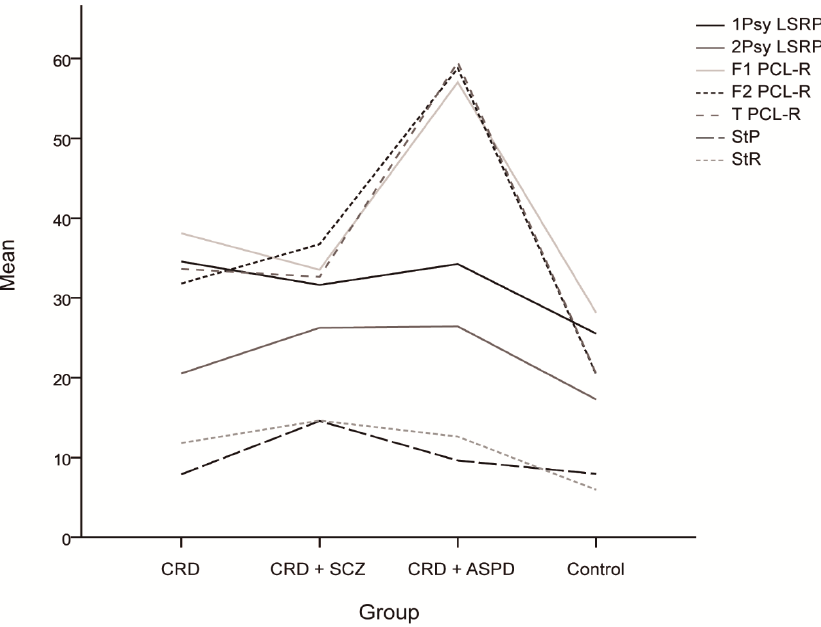
Figure 1. Mean scores and differences between the groups for the psychopathy scales and sensitivity to punishment and sensitivity to reward questionnaire. CRD: cocaine-related disorder; SCZ: schizophrenia; APD: antisocial personality disorder; 1Psy LSRP: primary psychopathy on the Levenson Self-Report Psychopathy Scale; secondary psychopathy on the Levenson Self-Report Psychopathy Scale; F1 PCL-R: interpersonal/affective factor on the Hare Psychopathy Checklist Revised; F2 PCL-R: social deviation factor on the Hare Psychopathy Checklist Revised; T PCL-R: total score on the Hare Psychopathy Checklist Revised; StP: sensitivity to punishment; StR: sensitivity to reward.